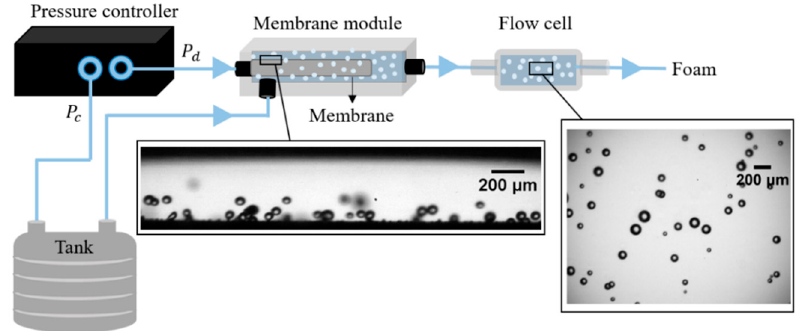
Figure 2. Schematic overview of the experimental set-up. The images show bubble formation at the membrane surface across from the continuous phase inlet and bubbles in the flow cell. The sche- matic is not drawn to